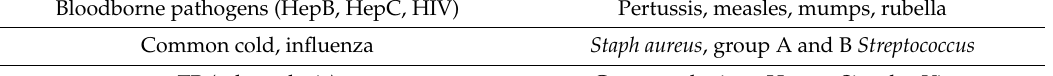
Table 6. Examples of hazards faced by nursing assistants in a focused review of the literature. Biological/Infectious Hazards: infectious agents capable of being transmitted to others via contact with infectious patients or their bodily fluids Bloodborne pathogens (HepB, HepC, HIV) Pertussis, measles, mumps, rubella Common cold, influenza Staph aureus , group A and B Streptococcus TB (tuberculosis) Cytomegalovirus, Herpes Simplex